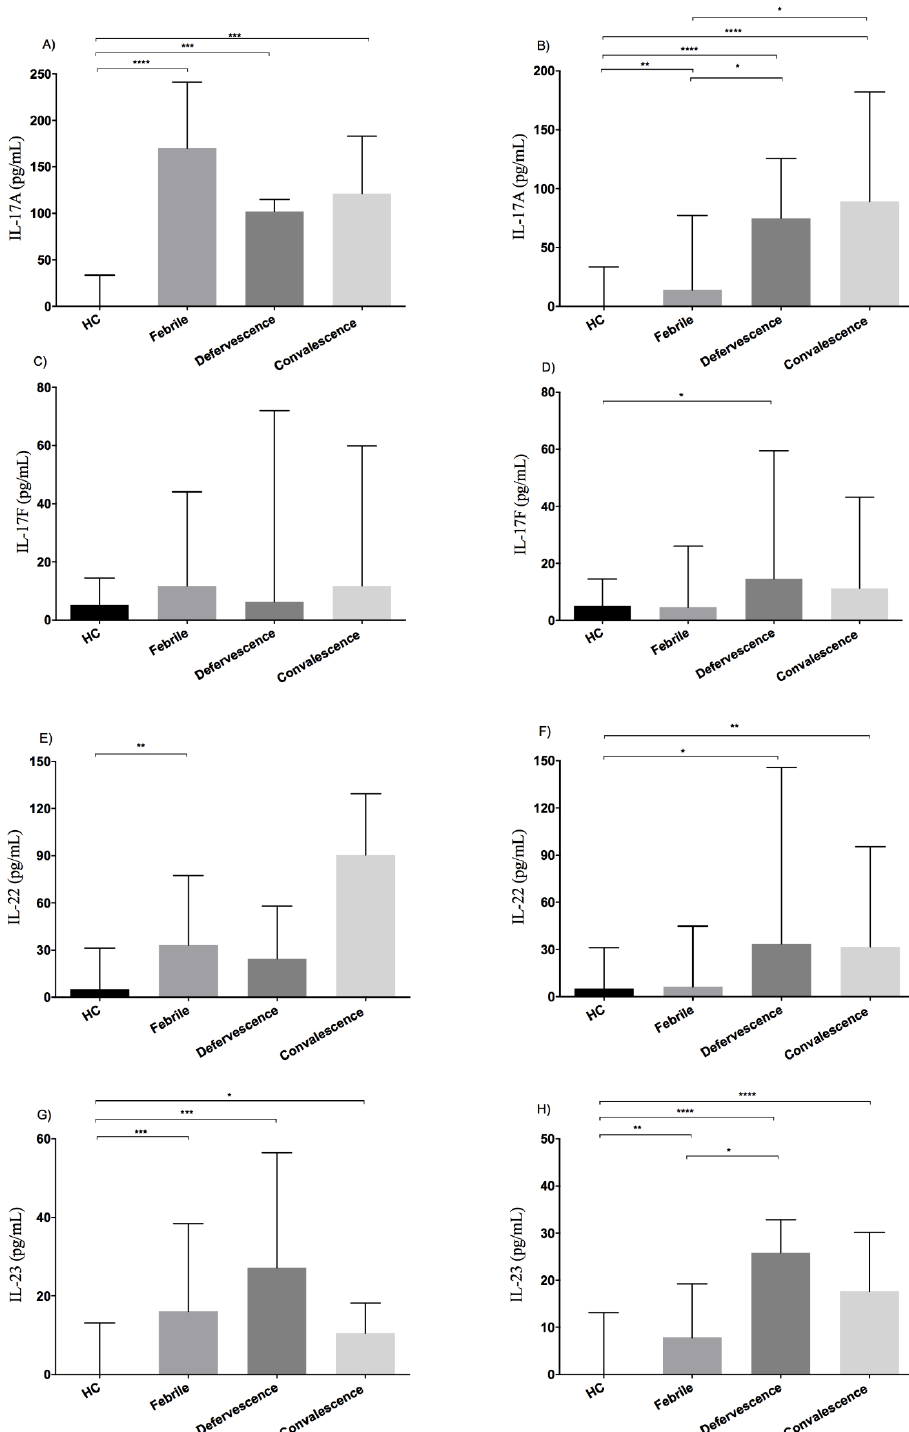
Figure 2. Dynamics of production of IL-17-related cytokines at di ff erent illness phases. Dengue patients were grouped according to illness phase (febrile, defervescence and convalescence) and infection type (primary and secondary). Median values of IL-17A serum levels are shown for primary ( A ) and secondary dengue infections ( B ), for IL-17F in primary ( C ) and secondary ( D ) infections, for IL-22 in primary ( E ) and secondary ( F ) infections and for IL-23 in primary ( G ) or secondary ( H ) infections. Individual data are shown and the horizontal line is the median value. Statistical di ff erence is based on the Kruskal–Wallis with Dunn’s multiple comparison post-tests. * p < 0.05, ** p < 0.01, *** p < 0.001, **** p <